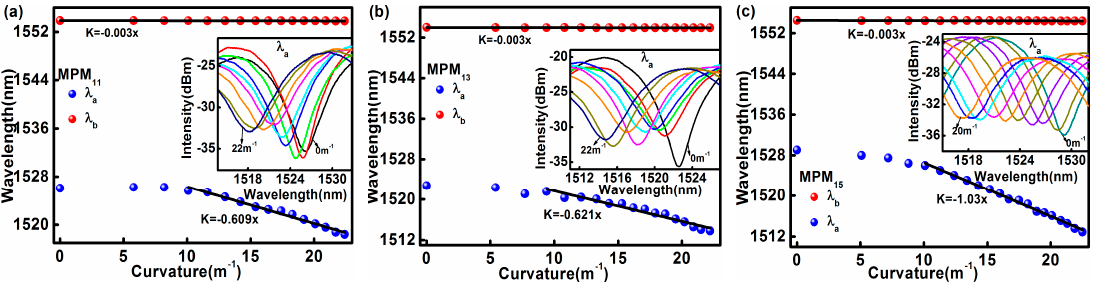
Figure 6. The curvatures characterization of λ a and λ b : ( a ) MPM 11 ; ( b ) MPM 13 ; and ( c ) MPM 15 .